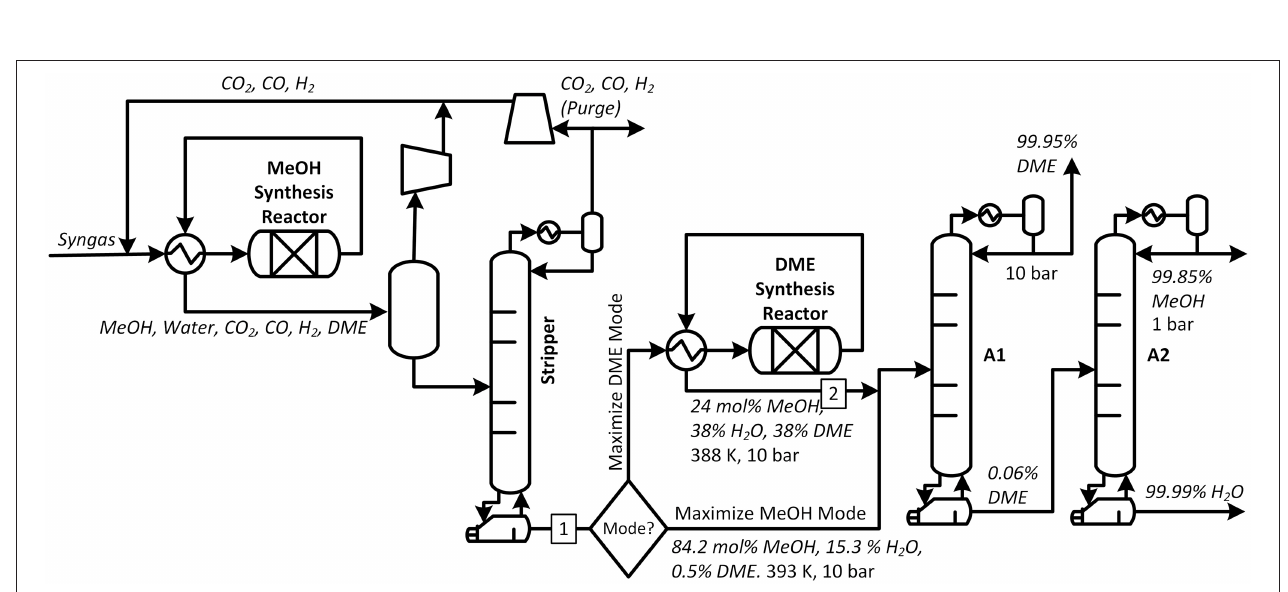
FIGURE 1 | Process overview for the base case design. In this system, syngas is converted to methanol (as well as DME, Water, and gaseous by-products) at steady state and uses a total of four distillation columns. During operation, the system can either be switched into Maximize DME Mode or Maximize Methanol Mode.